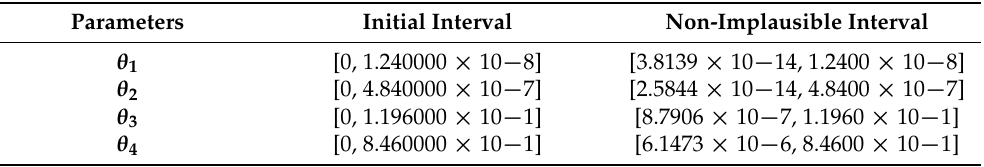
Table 3. Initial interval and non-implausible interval for each